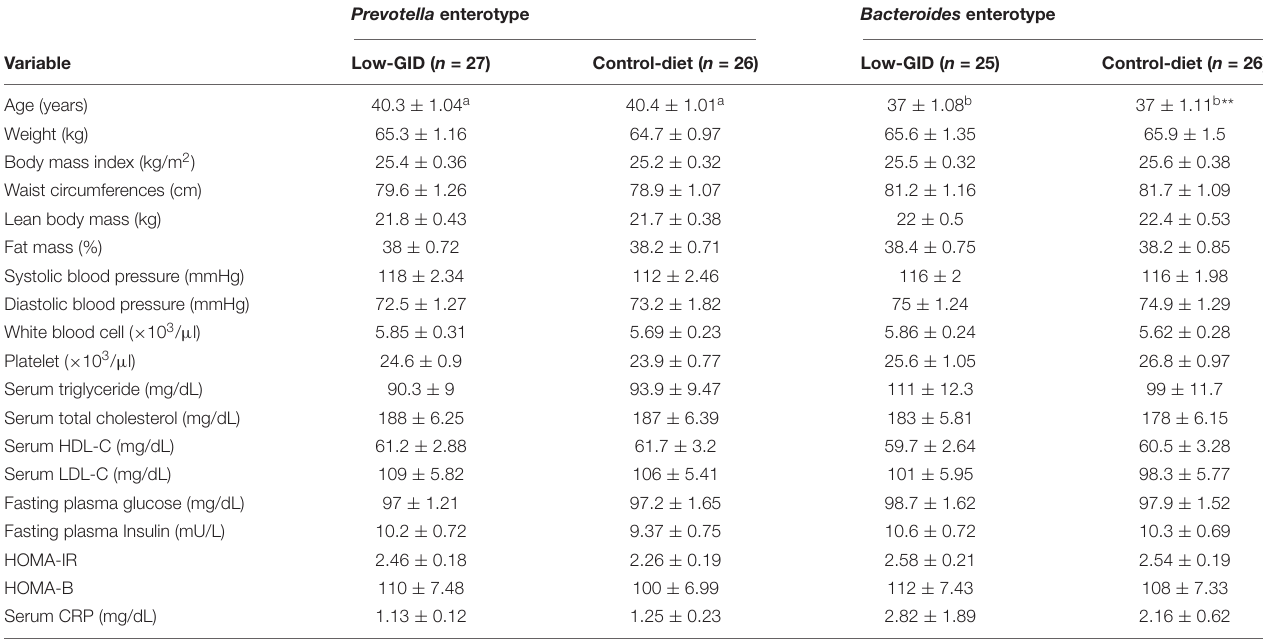
TABLE 2 | Baseline characteristics in a low-glycemic diet (Low-GID) representing Korean traditional balanced diet and westernized diet as a control diet (CD) according to enterotypes.